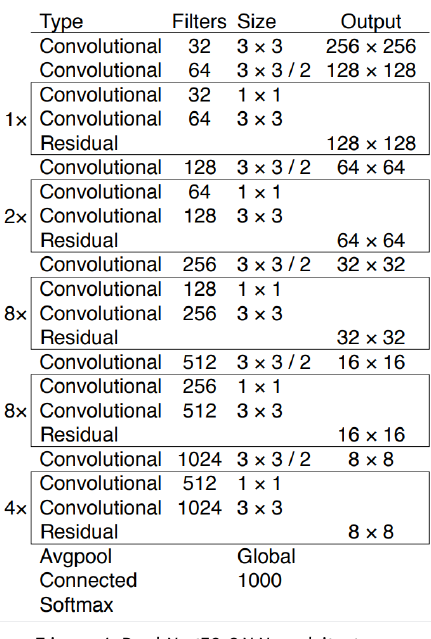
Figure 4. DarkNet53 CNN